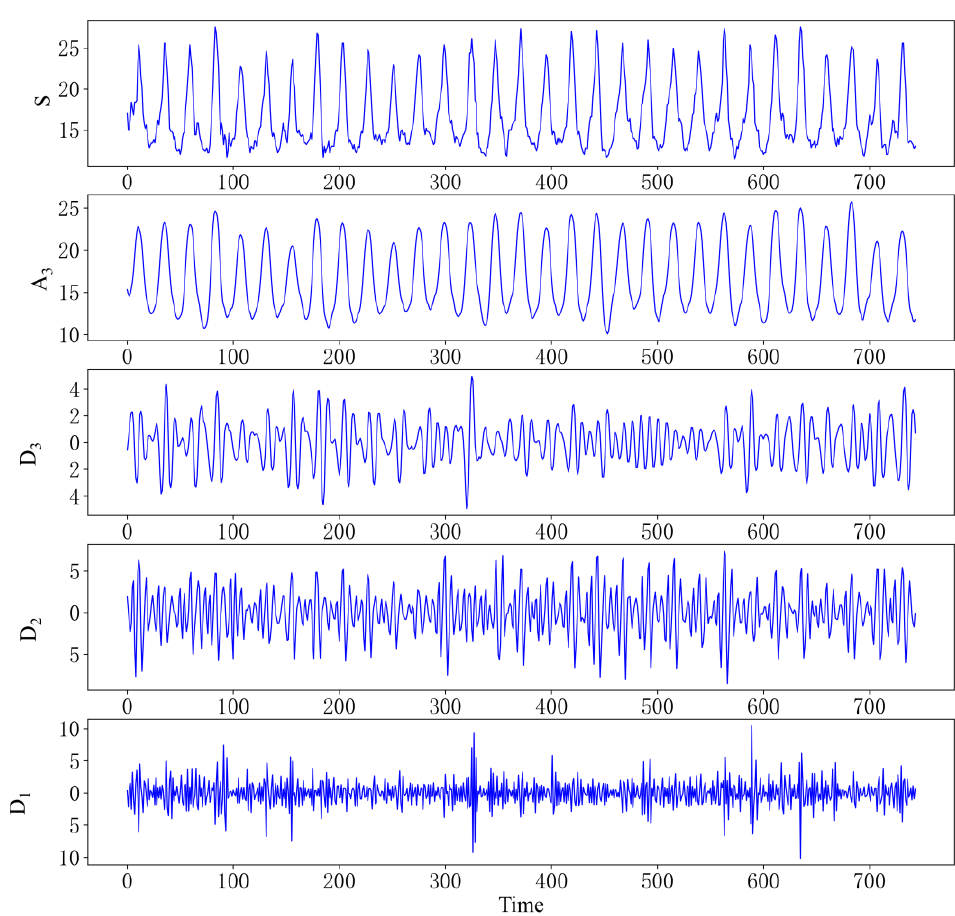
Figure 6. Three-layer wavelet decomposition.